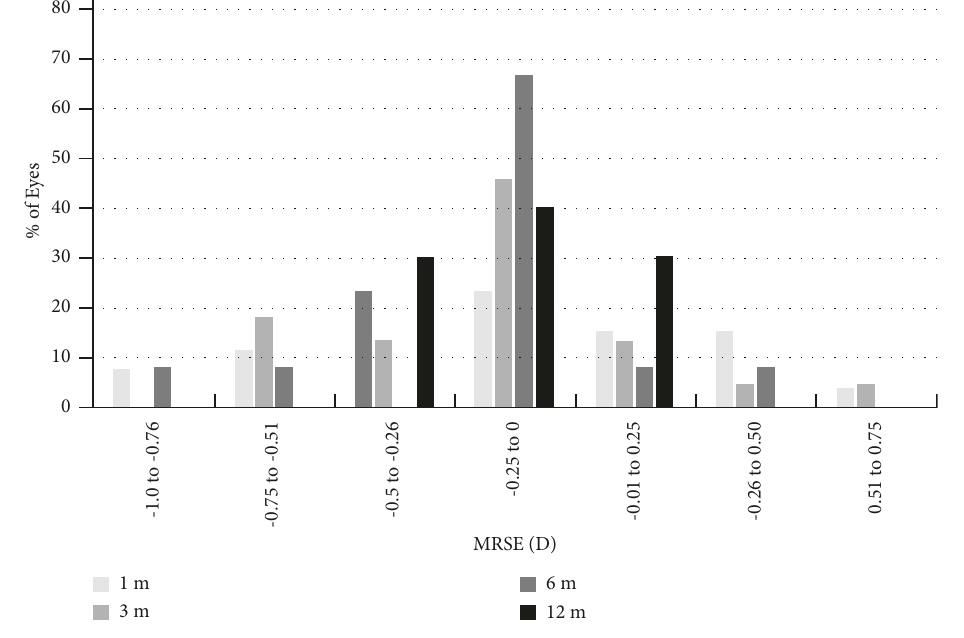
Figure 2: The distribution of postoperative manifest refraction spherical equivalent